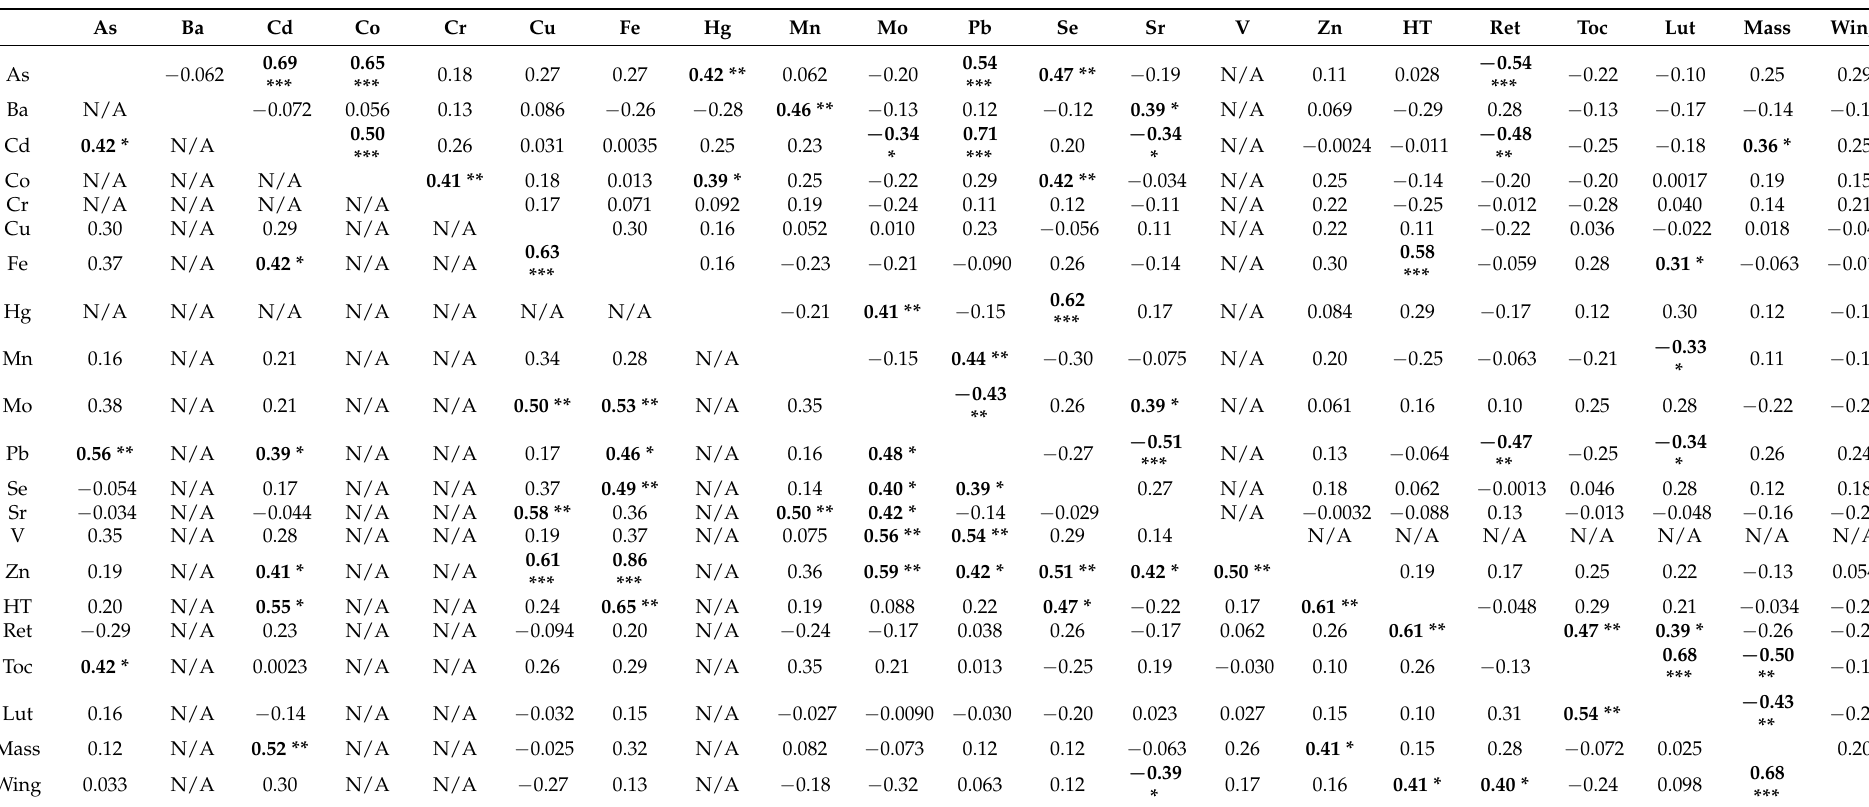
Table A1. Pearson correlations between blood elements, hematocrit (HT), plasma biochemistry, wing length, and body mass of Turdus merula (above diagonal, n = 42; for retinol, tocopherol, and lutein n = 40) and Columba livia (below diagonal, n = 27; for hematocrit n =